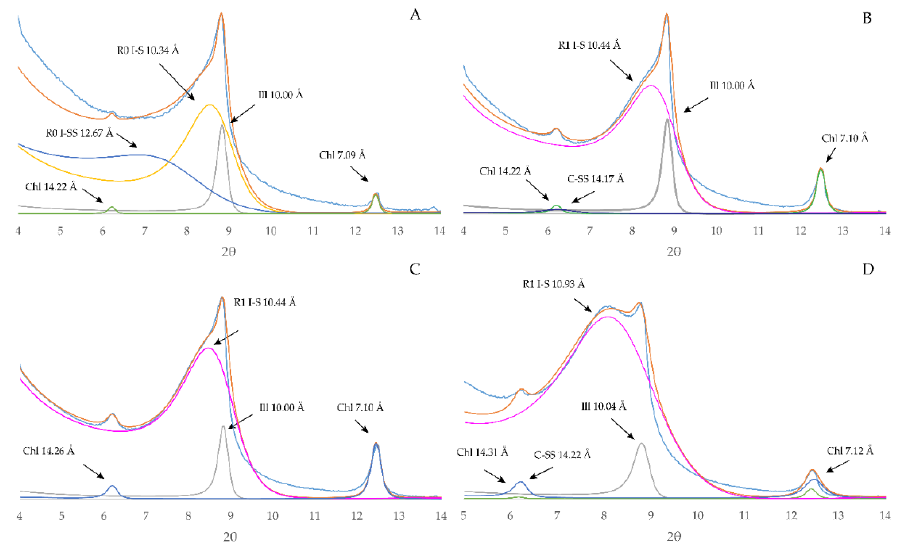
Figure 7. Deconvolution of XRD patterns of clay fraction for four representative samples. ( A -T401-7673, B -T401-8197, C -T401-8252, and D -JP Chilton-11118). The experimental XRD pattern is blue with the modeled fit being orange, with phases of illite (grey), chlorite (green), R0 I-S (yellow), R1 I-S (pink), R3 I-S (red), and R0 I-SS (dark blue).